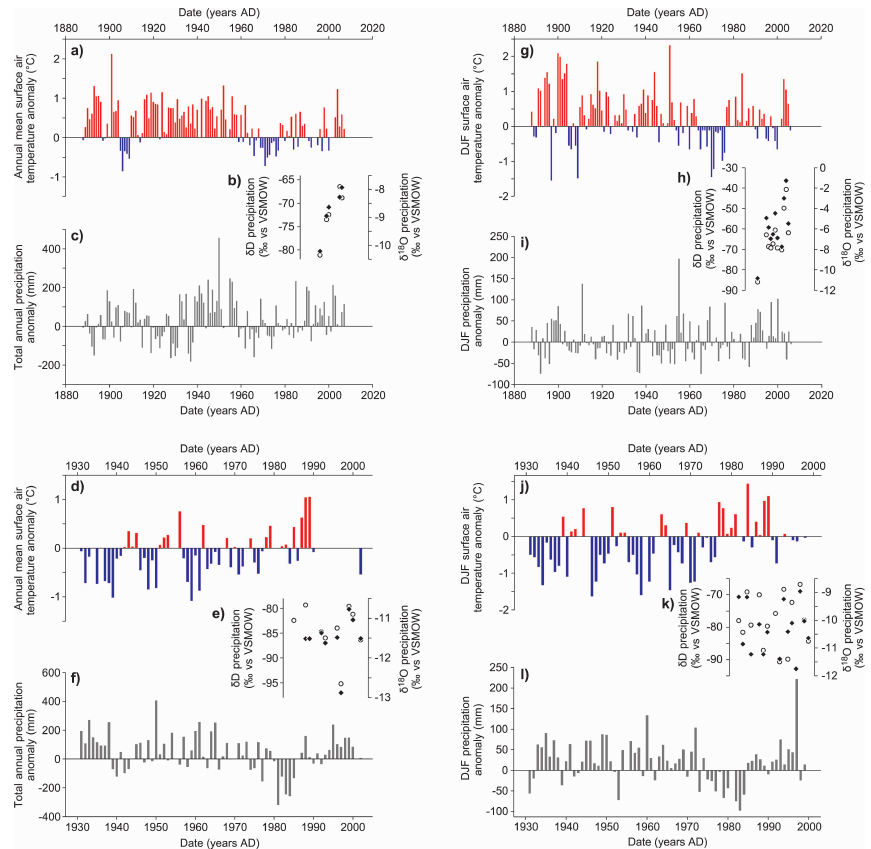
Fig. 4. Modern isotopic and climate timeseries from GNIP/WMO stations at Punta Arenas, Chile, and Ushuaia, Argentina. For Punta Arenas (top graphs): (a) mean annual surface air temperature anomaly ( ◦ C) relative to the 1961–1990 mean. (b) mean annual amount-weighted δ D values (open diamonds) and δ 18 O-values (open circles) in meteoric waters for years with complete twelve months of data between 1990 and 2008. (c) mean annual precipitation anomaly (mm) relative to the 1961–1990 mean. (g) mean DJF surface air temperature anomaly ( ◦ C) relative to the 1961–1990 mean. (h) mean DJF amount-weighted δ D-values (open diamonds) and δ 18 O-values (open circles) in meteoric waters for years with complete DJF sequences of data between 1990 and 2008. (i) mean DJF precipitation anomaly (mm) relative to the 1961–1990 mean. For Ushuaia (bottom graphs): (d) mean annual surface air temperature anomaly ( ◦ C) relative to the 1961–1990 mean. (e) mean annual amount-weighted δ D-values (open diamonds; linear regression, solid line) and δ 18 O-values (open circles; linear regression, dashed line) in meteoric waters for years with complete twelve months of data between 1982 and 2002. (f) mean annual precipitation anomaly (mm) relative to the 1961–1990 mean. (j) mean DJF surface air temperature anomaly ( ◦ C) relative to the 1961–1990 mean. (k) mean DJF amount-weighted δ D-values (open diamonds) and δ 18 O values (open circles) in meteoric waters for years with complete DJF sequences of data between 1982 and 2002. (l) mean DJF precipitation anomaly (mm) relative to the 1961–1990